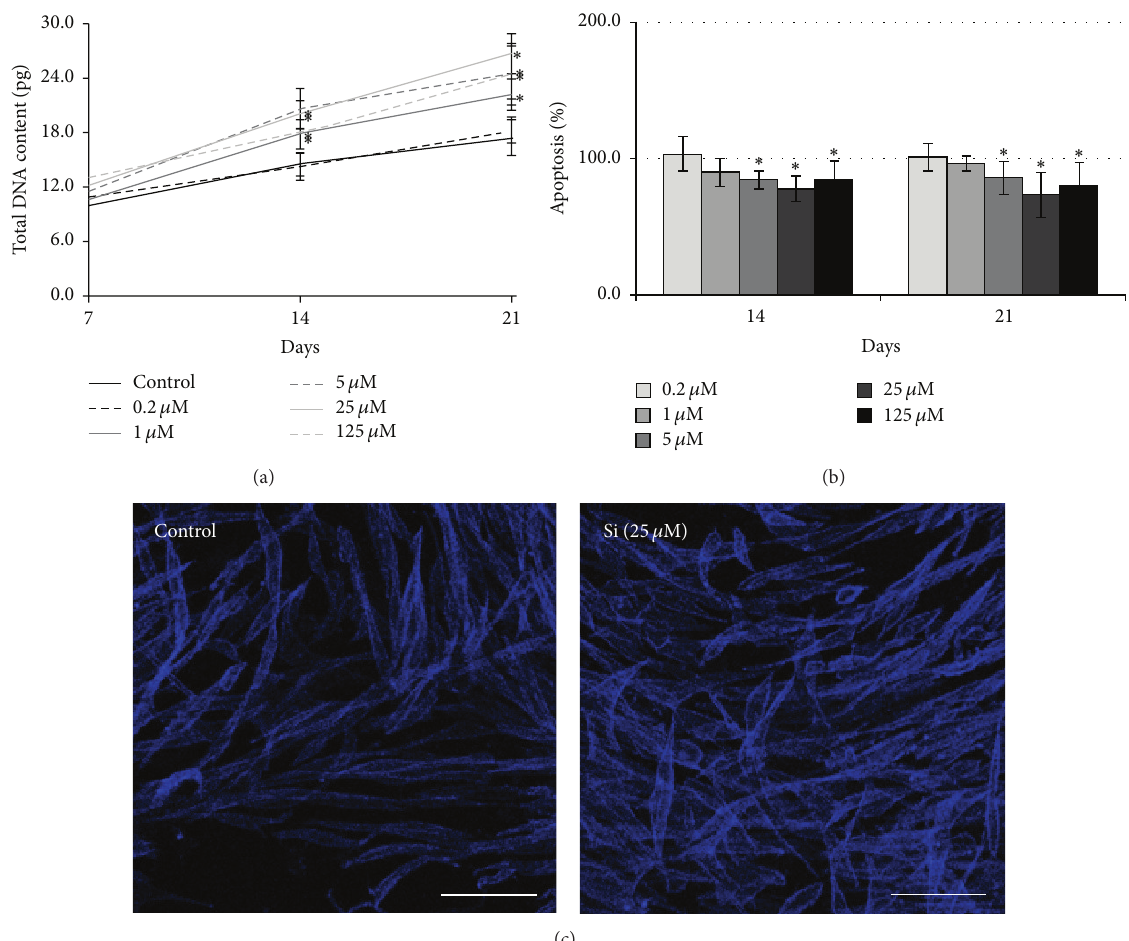
Figure 1: Effects of Si on cell density, apoptosis, and morphology of hMSC cultures. (a) Cellular density, determined by total DNA content; (b) apoptosis, determined by caspase-3 activity; (c) actin staining and visualization under confocal laser scanning microscopy. ∗ Significantly different than the control. White bars represent 150 𝜇